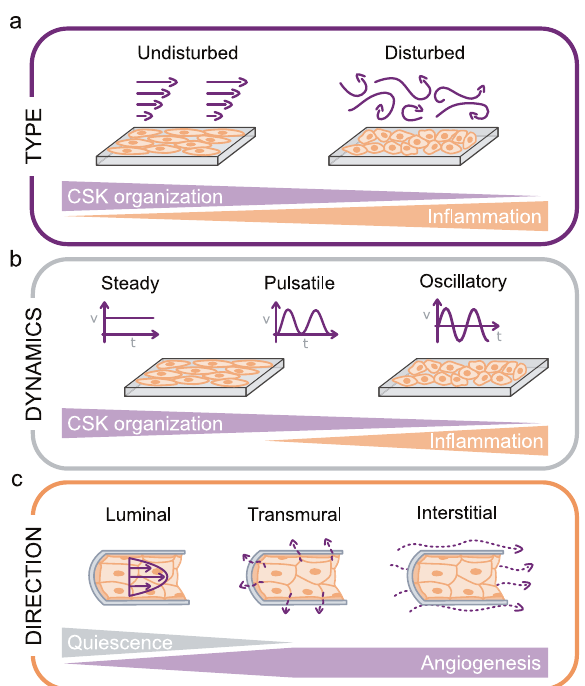
Fig. 3 Features of fl ow-induced shear stress experienced by endothelial cells (ECs). a ECs experience either undisturbed or disturbed fl ow, which have different effects on cytoskeletal (CSK) organization and the in fl ammatory state of the cells. b ECs can experience steady, pulsatile, or oscillatory fl ow. The fl ow dynamics in fl uence cytoskeletal organization and the in fl ammatory state of the cells. c ECs experience fl ow in the luminal direction (parallel to cells, on the apical side), transmural (across the endothelium, on cell – cell junctions), or interstitial (in the vessel wall or parenchymal tissue, on the basal side). The direction of the fl ow in fl uences EC quiescence and/or